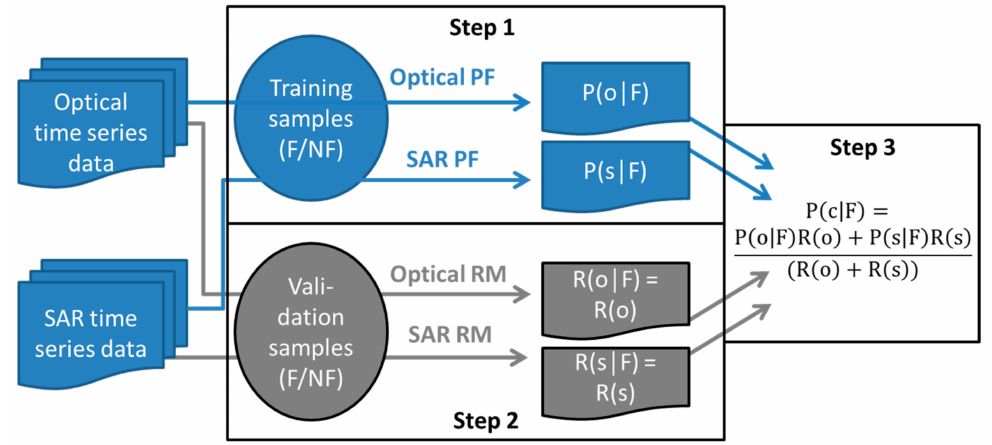
Figure 3. Schematic workflow of the Bayesian combination